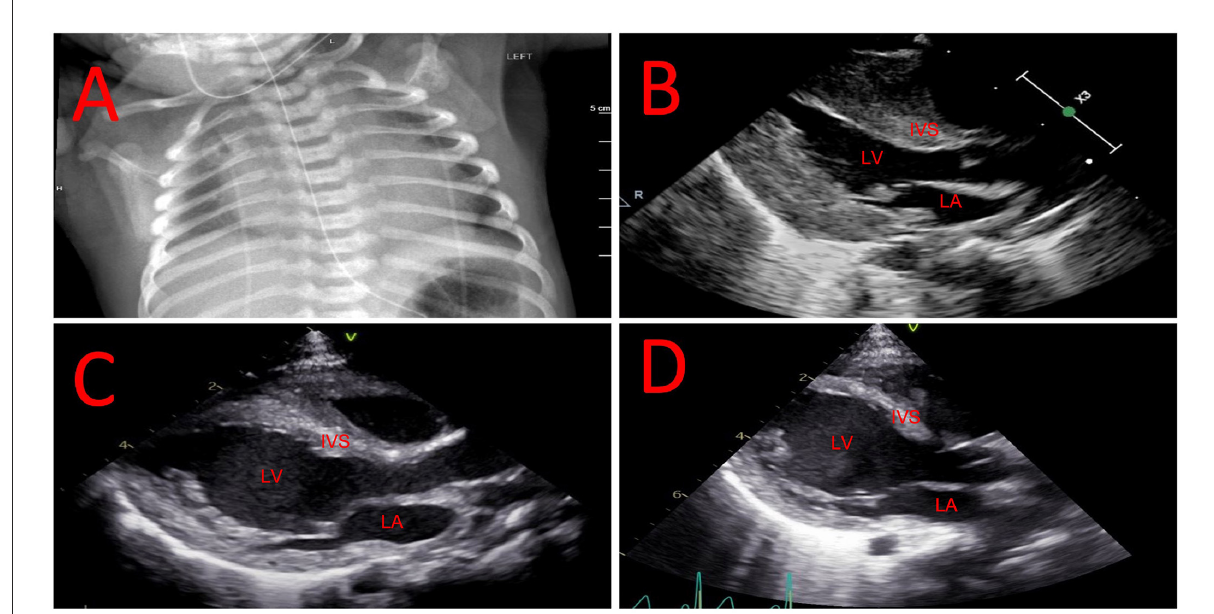
FIGURE1 Evolution of cardiac hypertrophy and dilation. (A) Chest radiograph showing marked cardiomegaly in the neonatal period. (B) Echocardiogram showing hypertrophic left ventricle in the neonatal period. (C) Echocardiogram showing mixed left ventricular hypertrophy and dilation at 2 months of age. (D) Echocardiogram showing resolution of left ventricular hypertrophy with worsening of dilation at 7 months of age. IVS, interventricular septum; LA, left atrium; LV, left